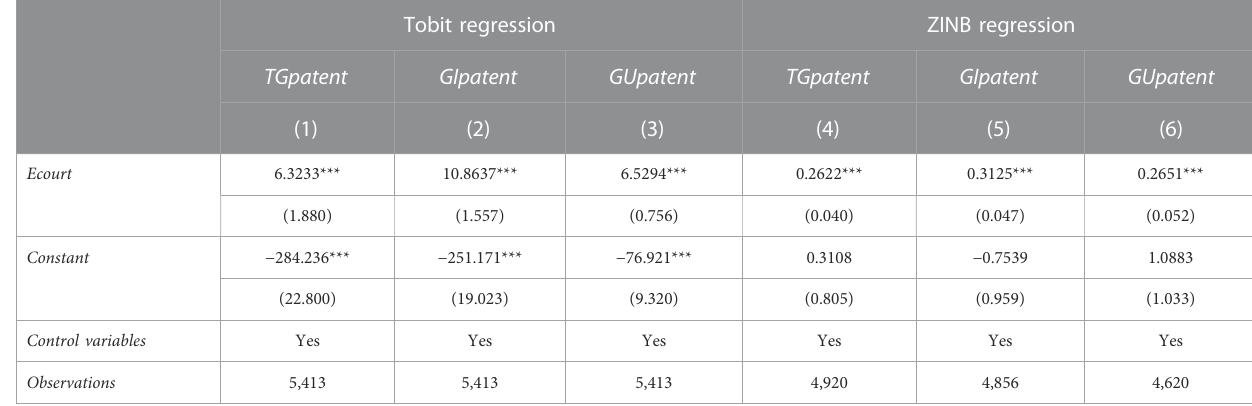
Figure 2. Supplementary Figures A3, A4 show the results for GIpatent and GUpatent in Supplementary Appendix A1. The distributions center around zero and most of the p -values are larger than 0.1. At the same time, our true estimators (red lines denote the true value of coef fi cients in Table 2) are clear outliers. These results indicate that our baseline results are not severely biased due to any random chance which veri fi es the robustness of our analysis.